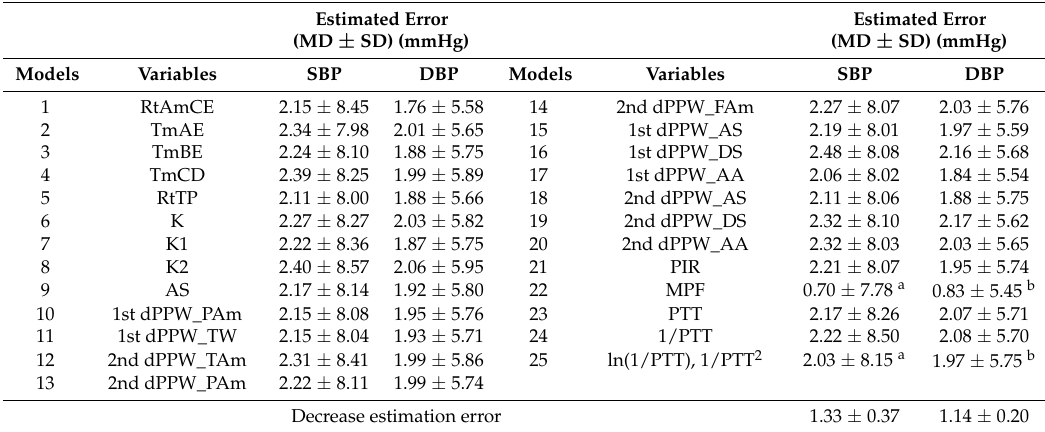
Table 3. Estimated BP errors of the PPW and PTT-based